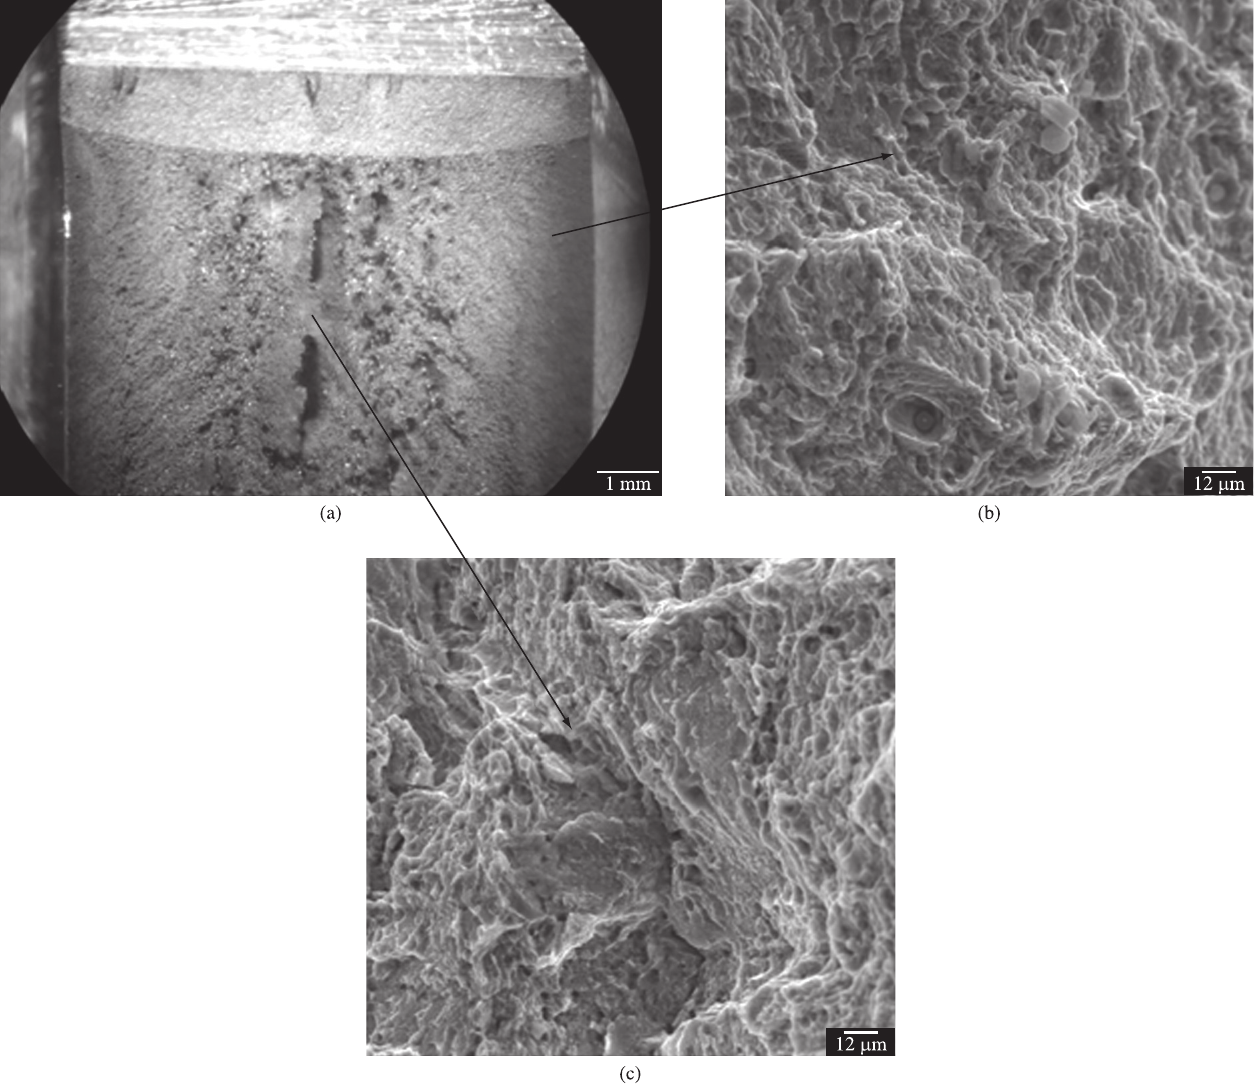
Figure 14. Fracture surface from steel B (0.017% of P) austenitized at 850 °C and tempered at 530 °C. a) General view of the fracture surface; b) detail from the instable crack growth; and c) detail from the fracture mode from the